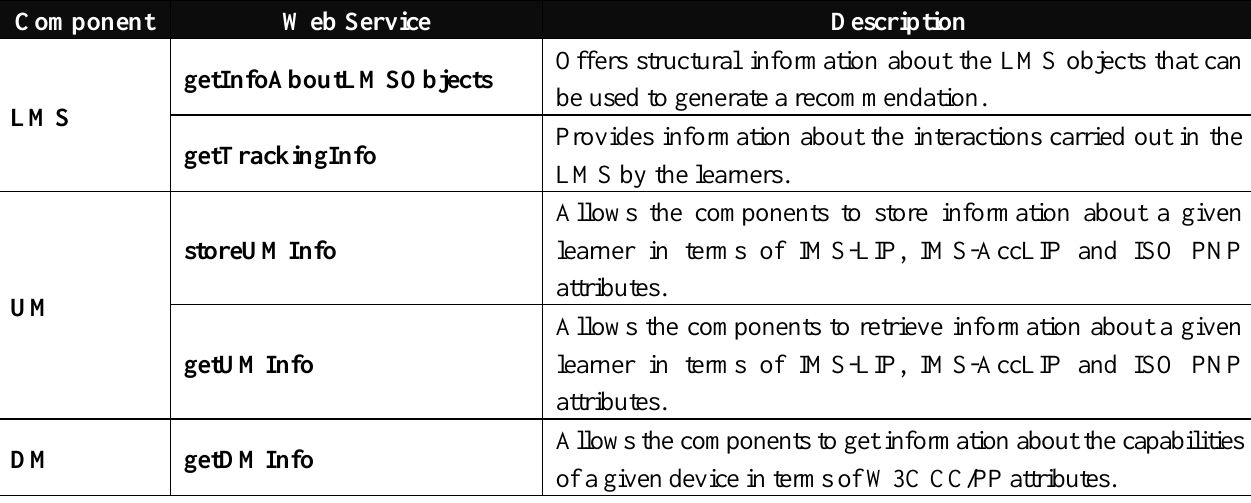
Table 6. Web services involved in the SOA that supports the SERS approach.